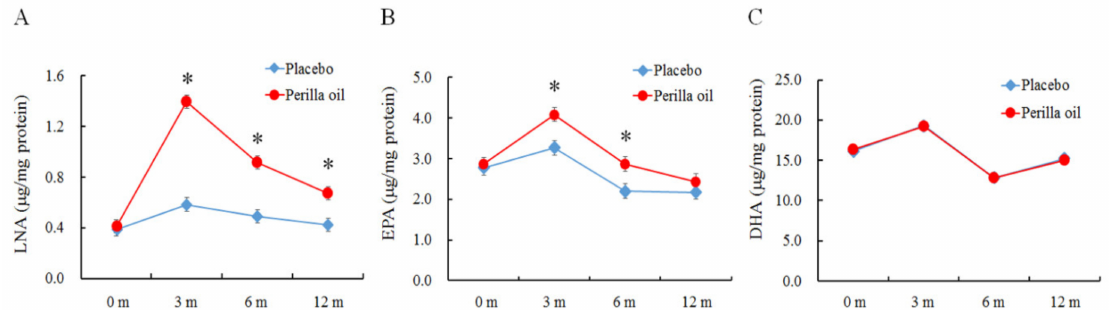
Figure 2. E ff ect on PO-administration on erythrocyte plasma membrane ( A ) LNA, α -linolenic acid; ( B ) EPA, eicosapentaenoic acid; and ( C ) DHA, docosahexaenoic acid. m: Months. Placebo, n = 34. Perilla oil, n = 31. Results are means ± SE. * p <